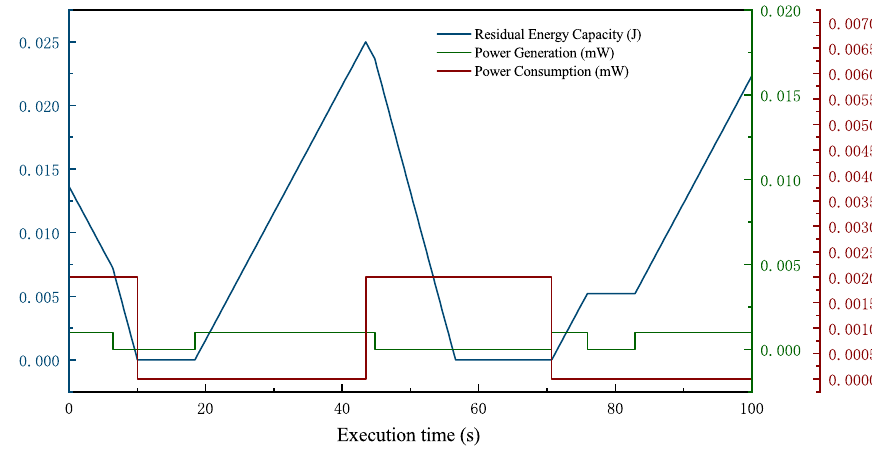
Figure 2. An example of single node energy